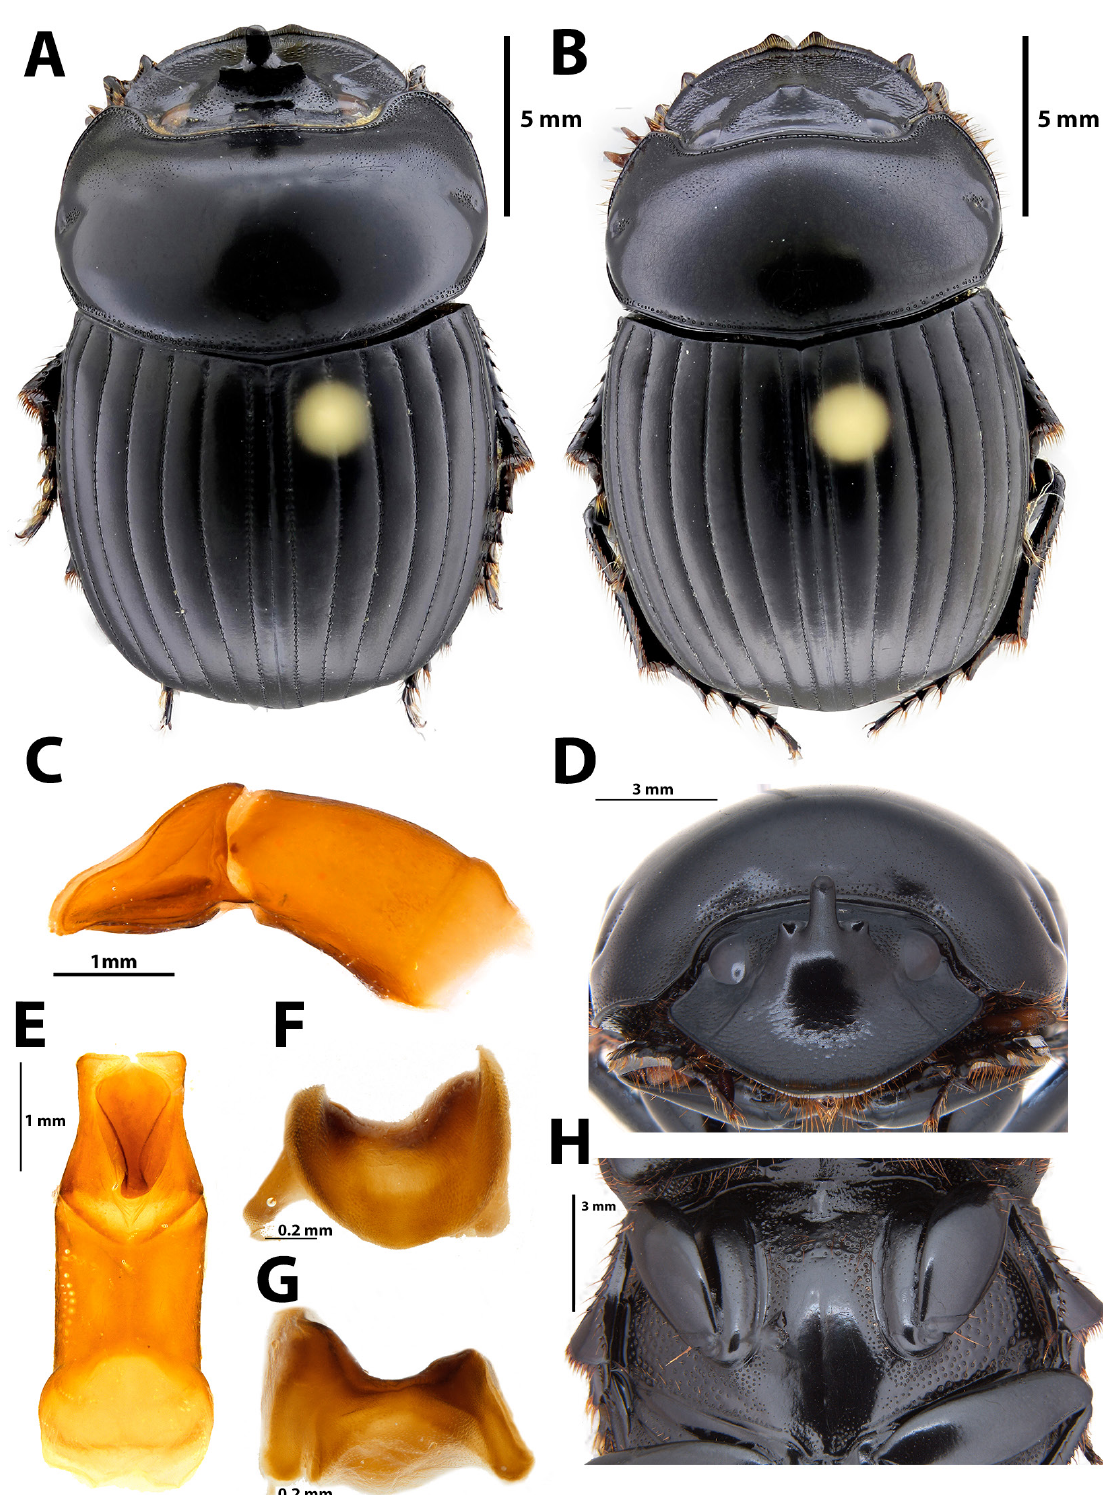
Fig. 10. Dichotomius henripittieri sp. nov. A–B . Dorsal habitus. A . Holotype, ♂ (CEMT). B . ♀. C . Lateral view of the aedeagus. D. Frontal view of the head, cephalic carina medial tubercle rounded at the apex. E . Dorsal view of the aedeagus. F–G . Lamella copulatrix. H . Ventral view of the metasternum, mesocoxa surrounded by multiple ocellate punctures, medial disc